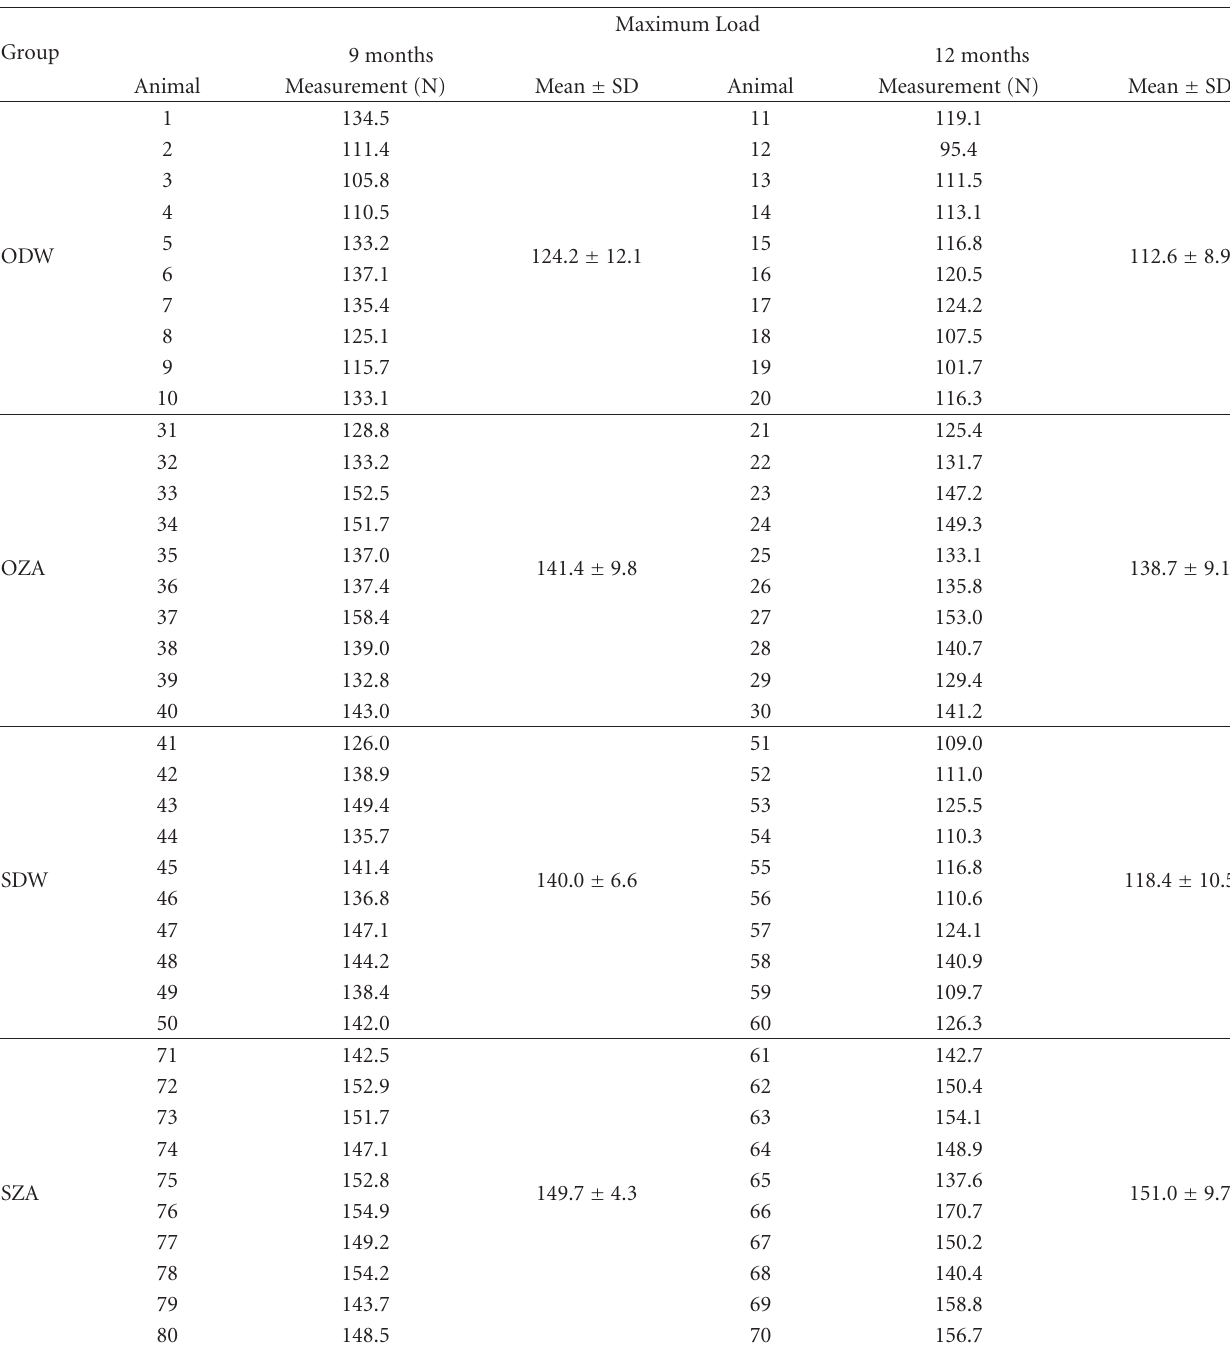
Table 1: Maximum load (N) at 9 and 12